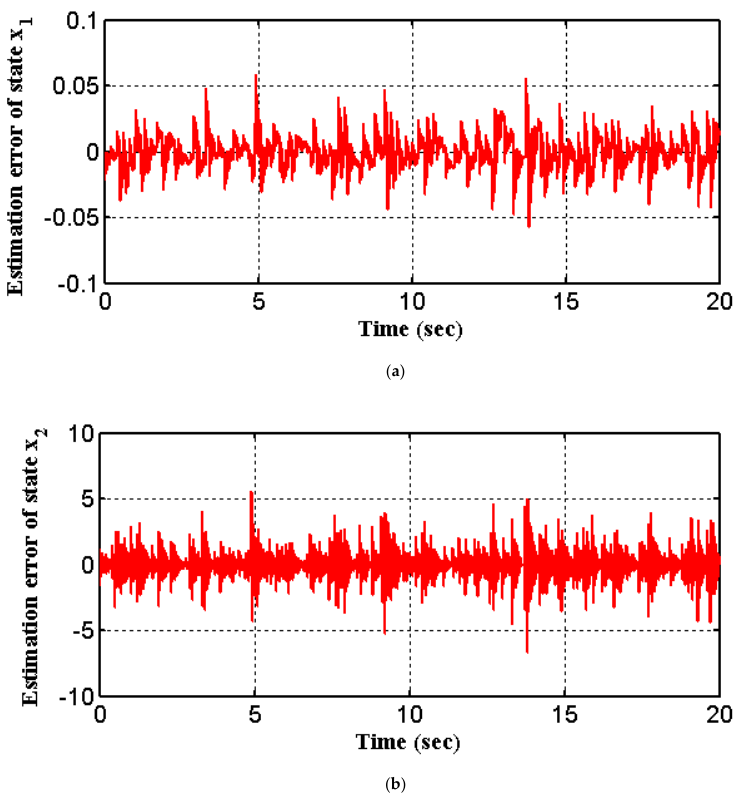
Figure 9. Estimation errors without measurement noise using C-ADRC, ( a ) (cid:1857) (cid:2869) ( b ) (cid:1857) (cid:2870) .